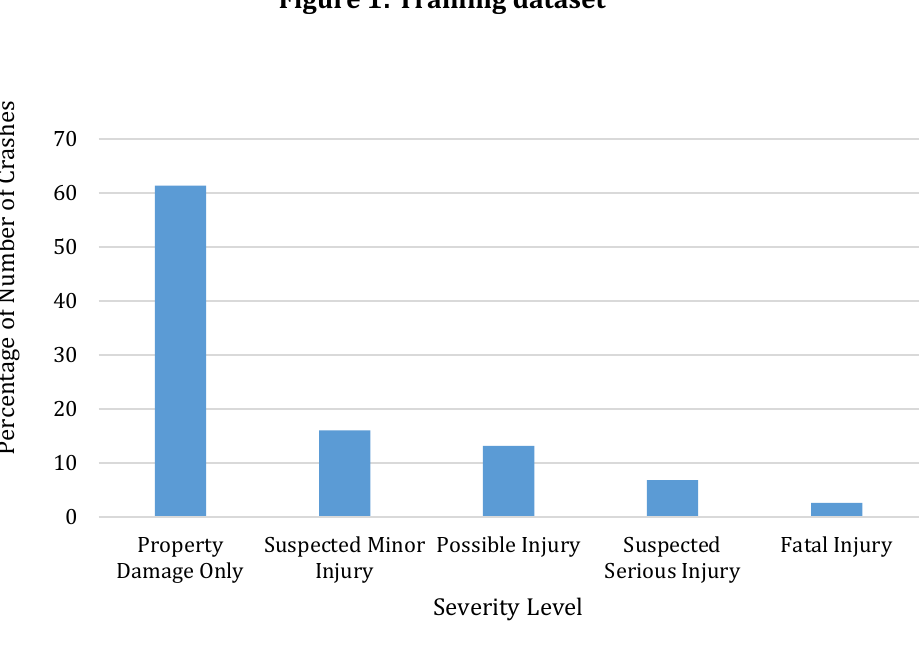
Figure 1: Training